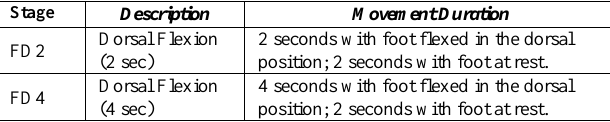
Figure 4. Game general score